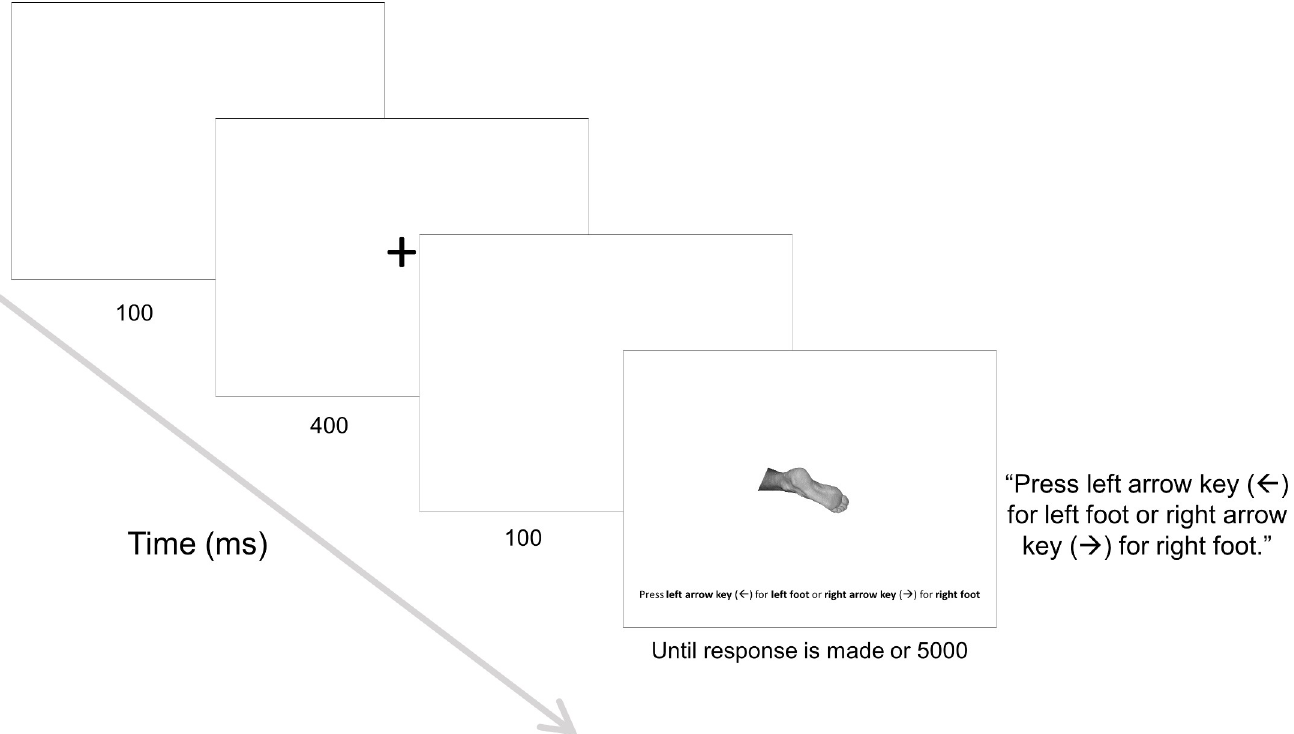
Fig 2. Example trial in the mental rotation task. Image depicts the sequence for a single trial in the mental rotation task. Participants responded to the laterality of the pictured foot by pressing the left arrow key (for left foot judgement) or the right arrow key (for right foot judgement).